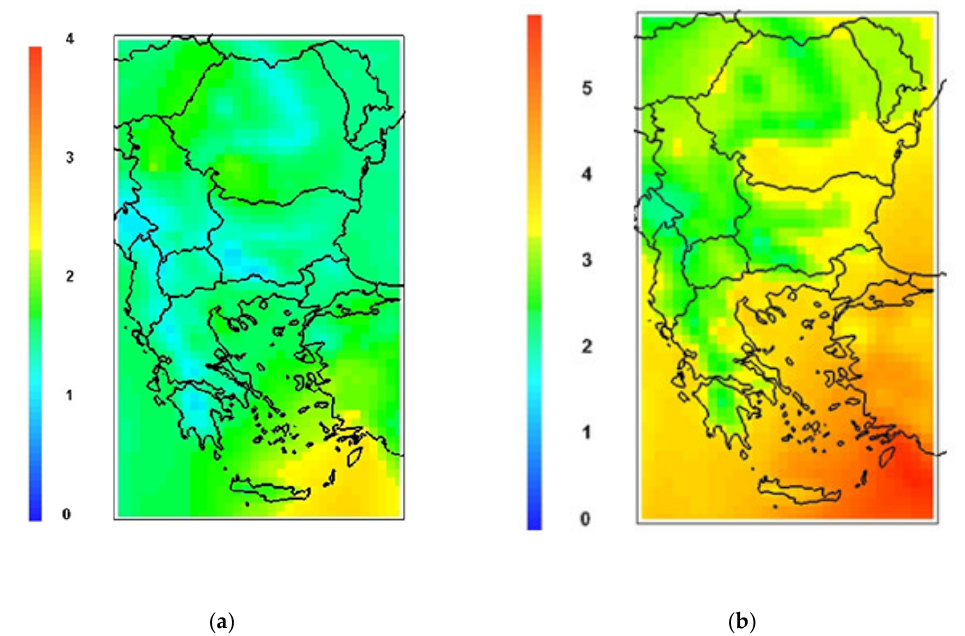
Figure 5. Monthly mean AOD in domain Balkan Peninsula for August 2017, ( a ) from BgCWFS_mod; ( b ) from BgCWFS_sat. Note different scales.